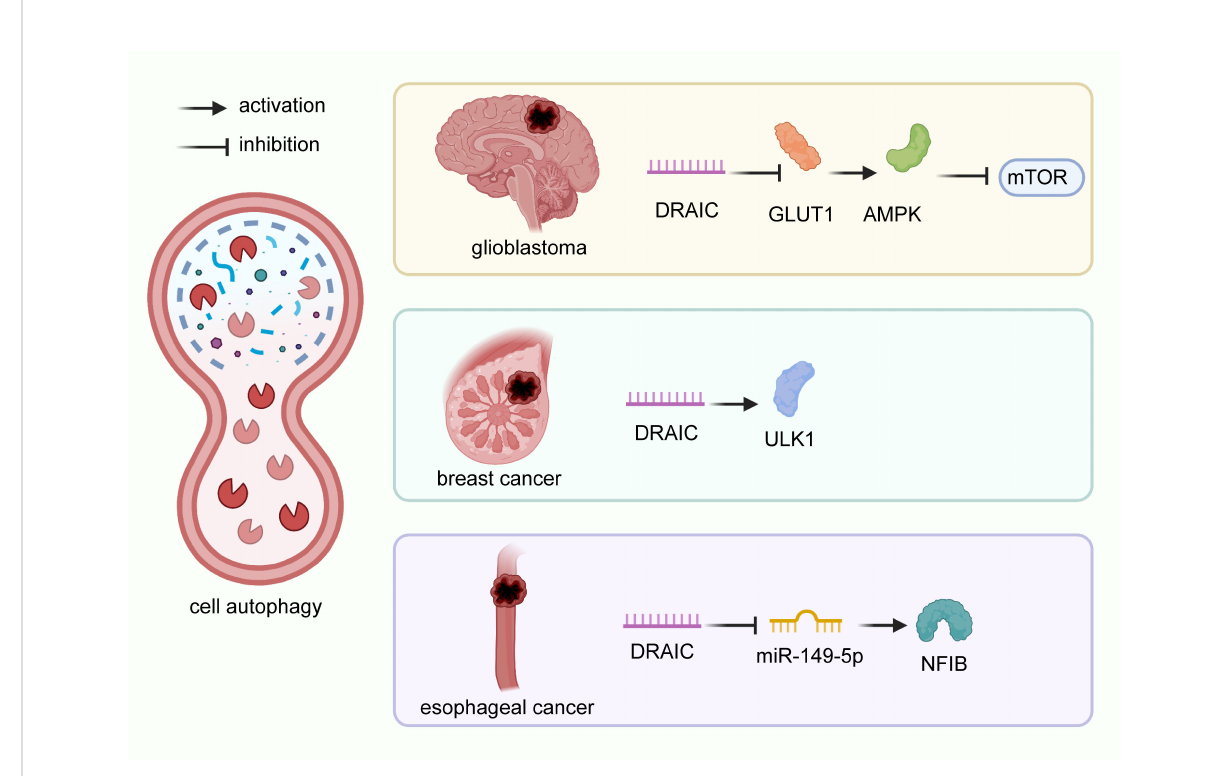
FIGURE 3 Regulatory mechanisms of DRAIC on cell autophagy in cancers. In glioblastoma A172 and U87 cells, lncRNA DRAIC induced autophagy by downregulating the NF- k B target gene GLUT1, which activated AMPK, and blocked the expression of mTOR. In breast cancer MCF-7 cells, DRAIC enhanced ULK1 expression and inhibited cell autophagy. In esophageal cancer, lncRNA DRAIC suppressed cell autophagy through its interaction with miR-149-5p and up-regulation of